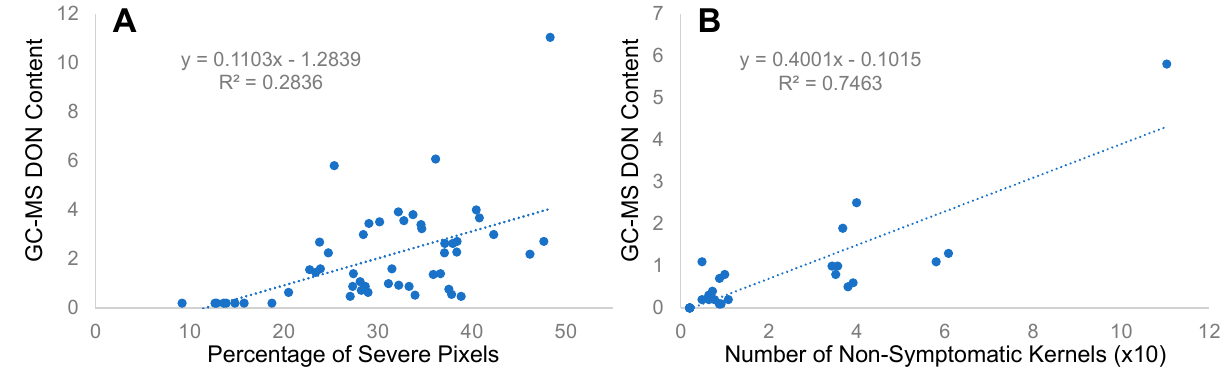
Figure 4. Correlation results between ( A ) percentage of severe pixels and GC-MS DON content and ( B ) GC-MS DON and number of severe kernels (with 70% threshold).